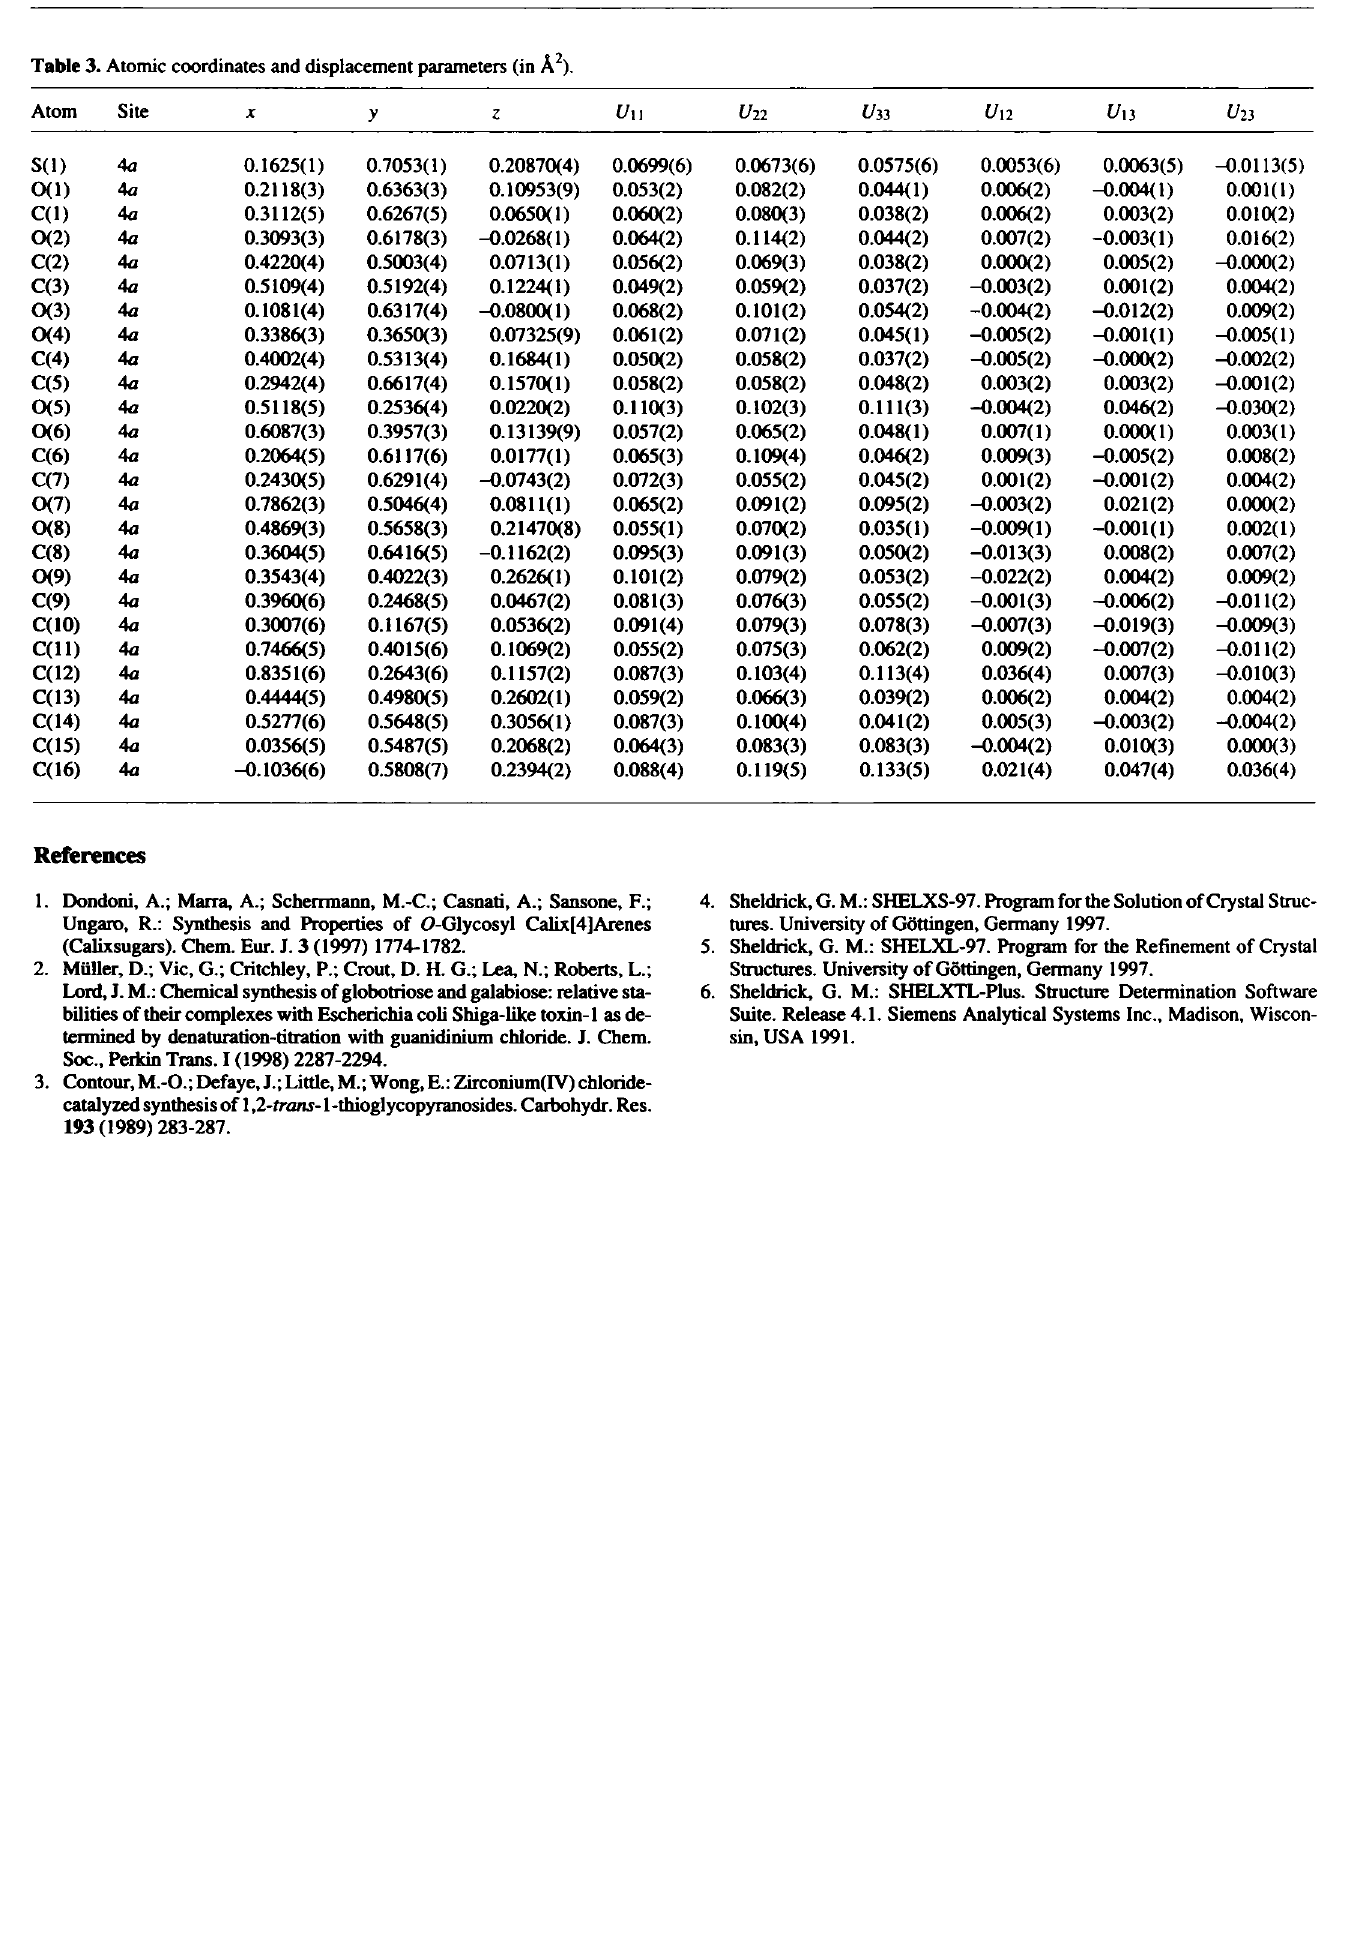
Table 3. Atomic coordinates and displacement parameters (in Â 2